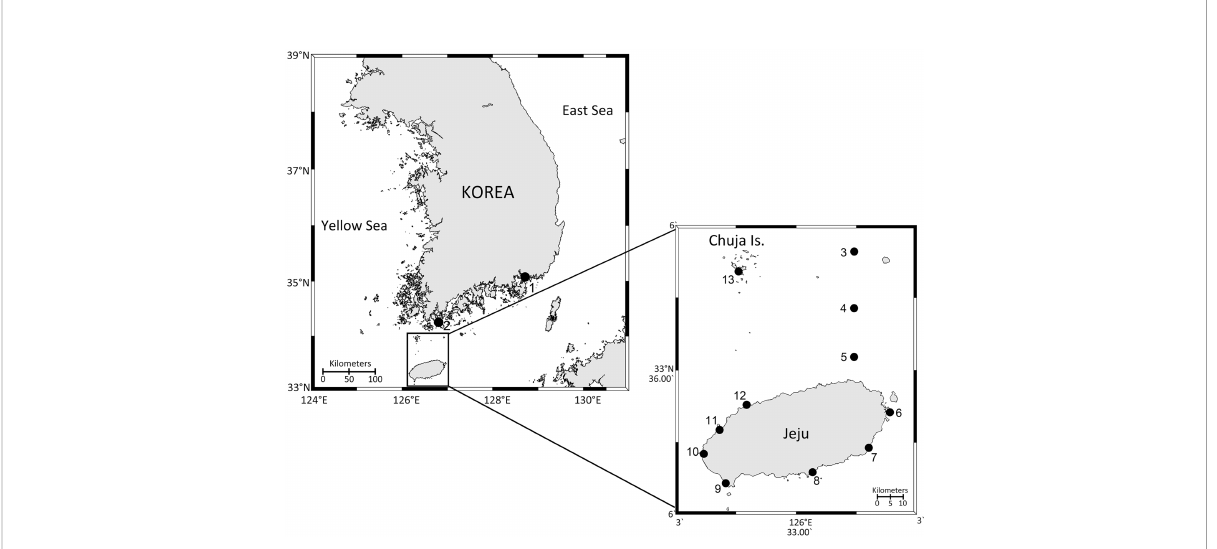
FIGURE 1 Map of the study area showing the sampling sites. 1, Jangcheon; 2, W1; 3, W4; 4, W6; 5, W8; 6, Seongsan; 7, Pyoseon; 8, Hahyo; 9, Unjin; 10, Jagunae; 11, Gemneung; 12, Aewol; 13, Sinyang. Circles 2 – 5 are microplastic sampling sites. Circles 1 and 6 – 13 are macroplastic sampling